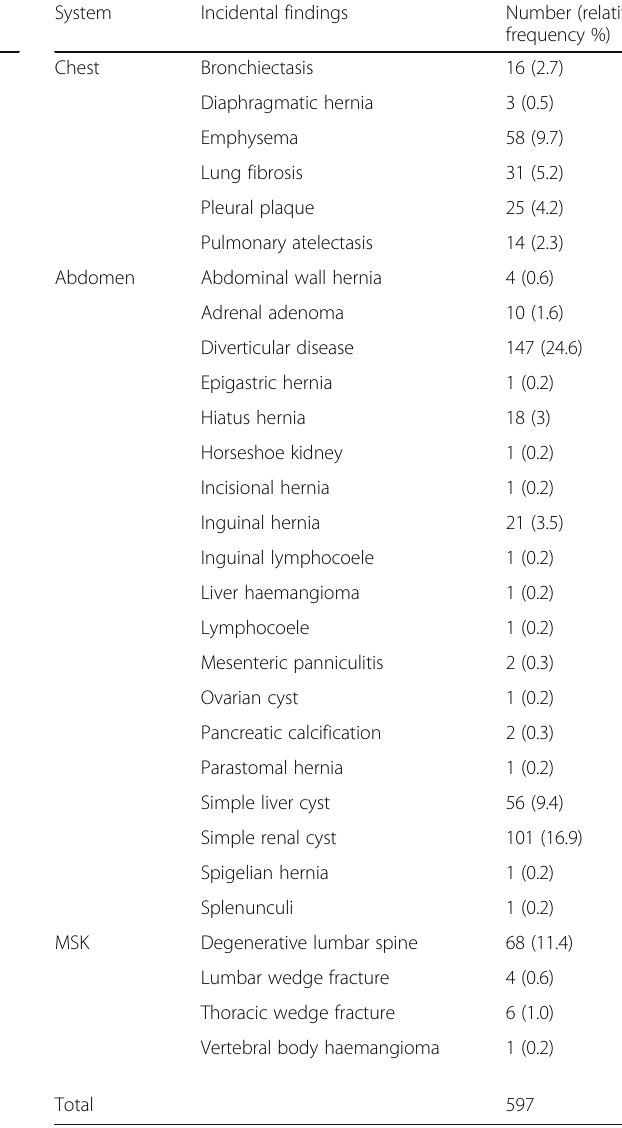
Table 4 Class III extravascular incidental findings according to system area. (MSK denotes musculoskeletal)